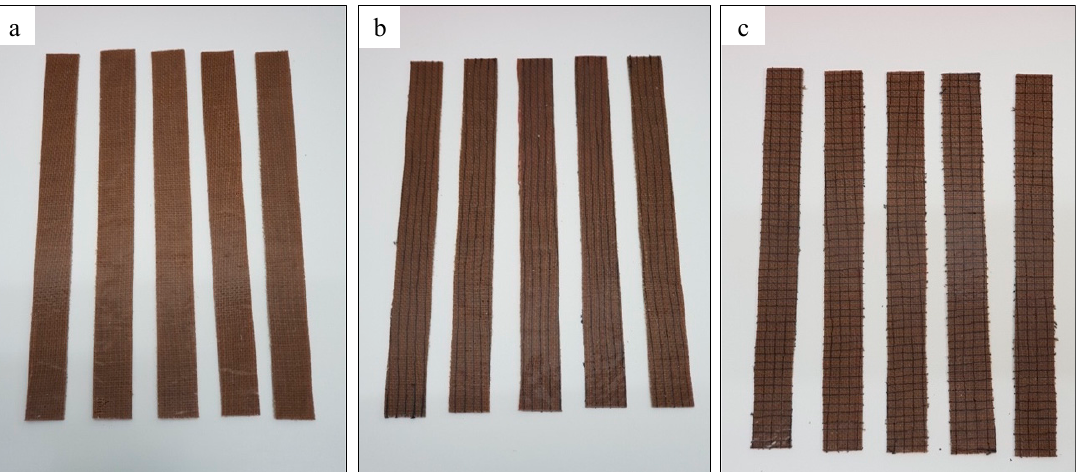
Figure 4. Tensile test setup using an Instron universal testing machine model 3365.